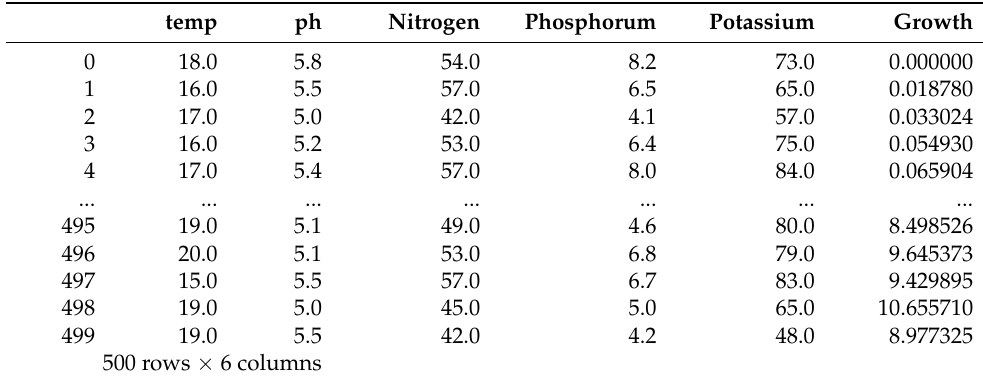
Table 1. Data set collected from Arduino unit with Raspberry Pi.